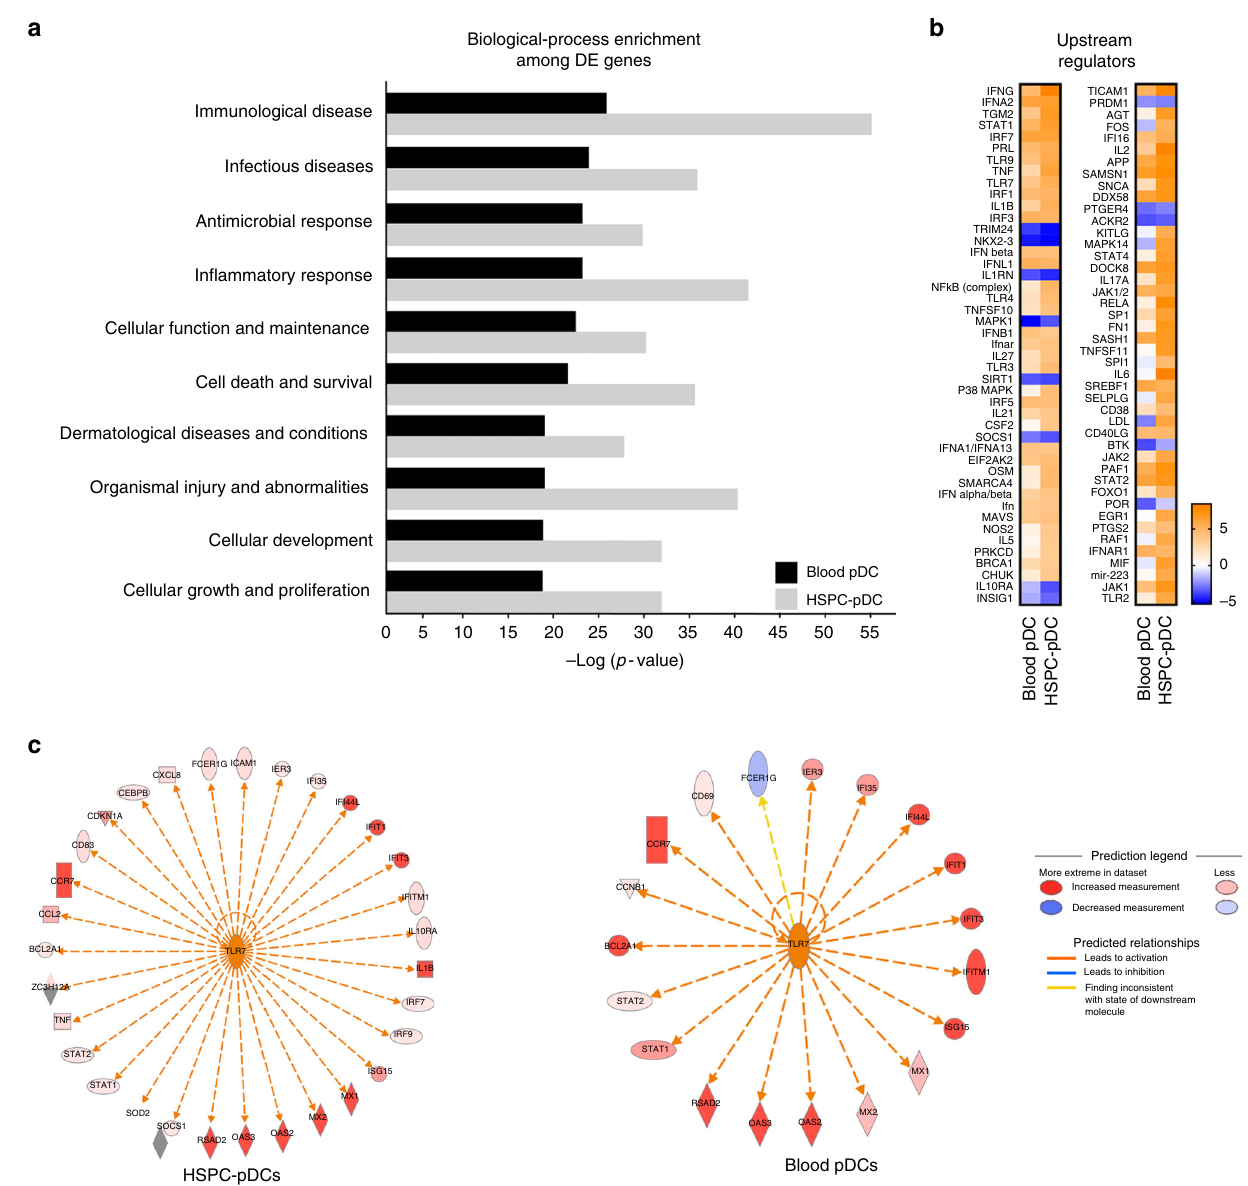
Fig. 4 HSPC-pDCs and blood pDCs exhibit shared transcriptomic pathways. a Top 10 biological processes enriched in the set of differentially expressed genes and their associated P values for blood pDCs (black) and IFN-primed HSPC-pDC (gray) after 24 h stimulation with a TLR7 agonist. b Heat map ( z -score) of both activated and inhibited upstream regulator genes within the top biological process corresponding to panel ( a ). c Illustration of regulated genes within the TLR7 pathway of after stimulation of blood pDCs and HSCP-pDC,